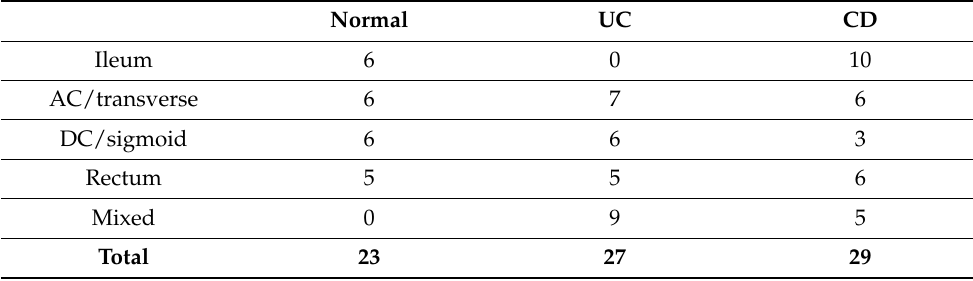
Table 1. Sample number per